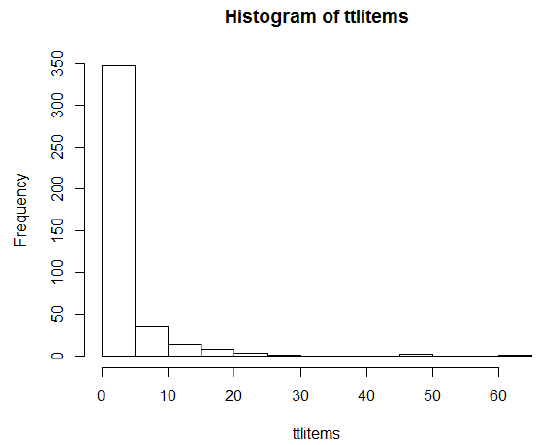
Figure 1. Distribution of scientists by number of publications during 2008–2017 (“ttlitems”).